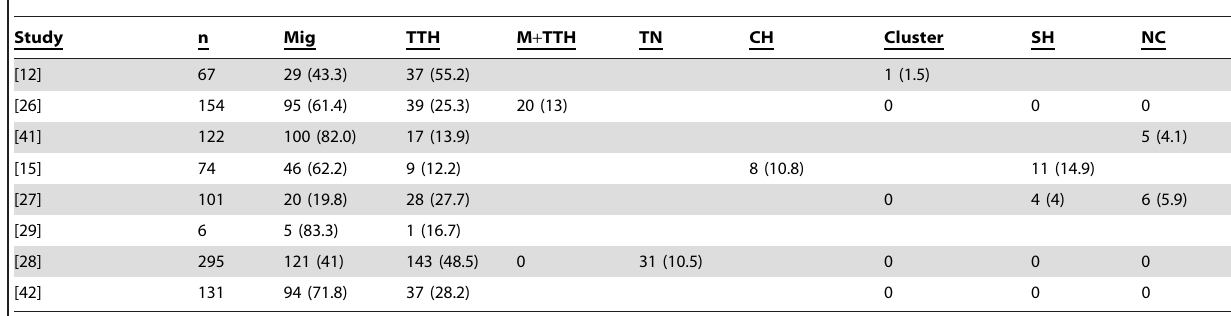
Table 1. Compilation of headache subtypes in